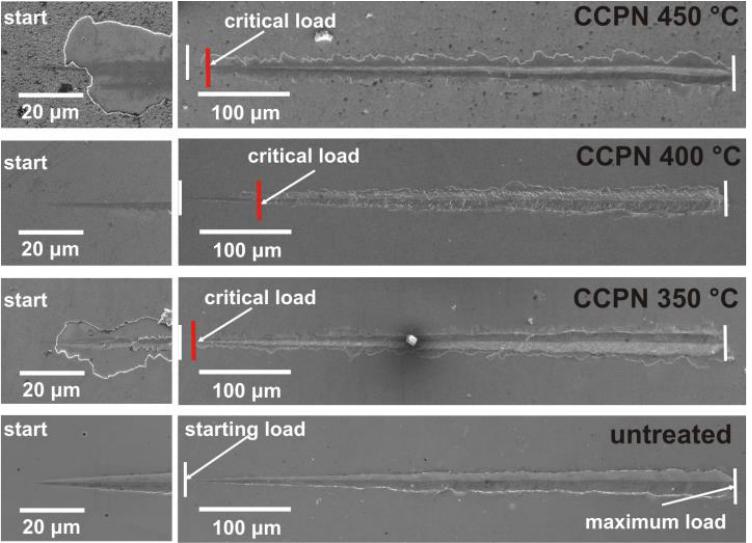
Figure 15. Nanoscratch micrographs of untreated and CCPN-treated AISI 316 steel samples obtained by SEM.